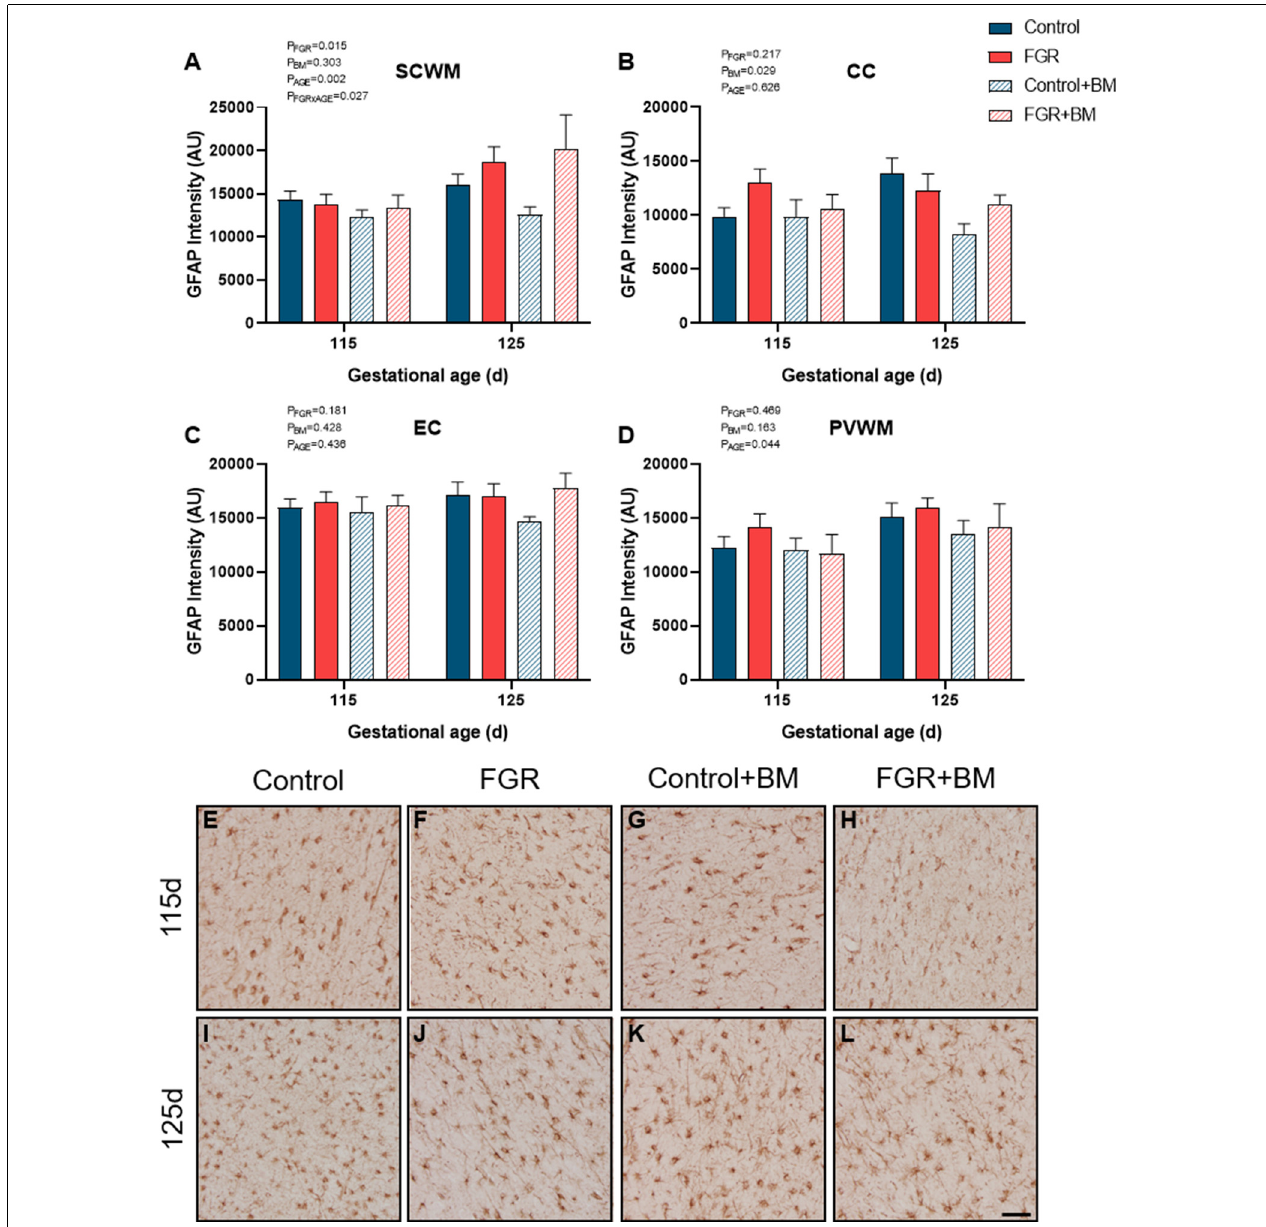
FIGURE 5 | GFAP immunoreactivity. The intensity of GFAP positive staining in the SCWM (A) , CC (B) , EC (C) and PVWM (D) and photomicrographs of the SCWM from 115 days control (E) , FGR (F) , control+BM (G) , FGR+BM (H) and 125 days control (I) , FGR (J) , control+BM (K) and FGR+BM (L) fetuses. Data are presented as mean ± SEM, scale bar = 50 µ